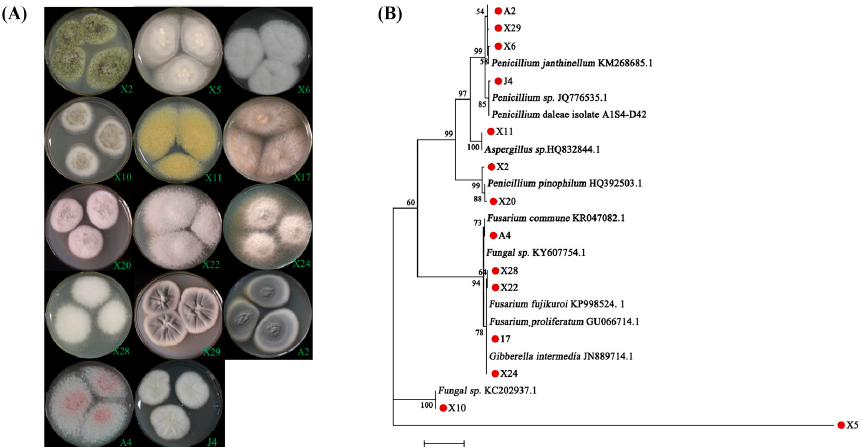
Figure 1. Colony features and phylogenetic tree of ITS sequences derived from endomycorrhizal fungi isolated from blueberry plant roots. ( A ) X2, X5, X6, X10, X11, X17, X20, X22, X24, X28, and X29 were isolated from the blueberry variety “Sharpblue”. A2 and A4 were isolated from the “O’Neal” variety. J4 was isolated from the variety known as “Premier”. ( B ) Phylogenetic analysis was performed by the MEGA software (version 7.0) using the maximum-likelihood algorithm. Numbers in the figure represent bootstrap values (1000 replicates).